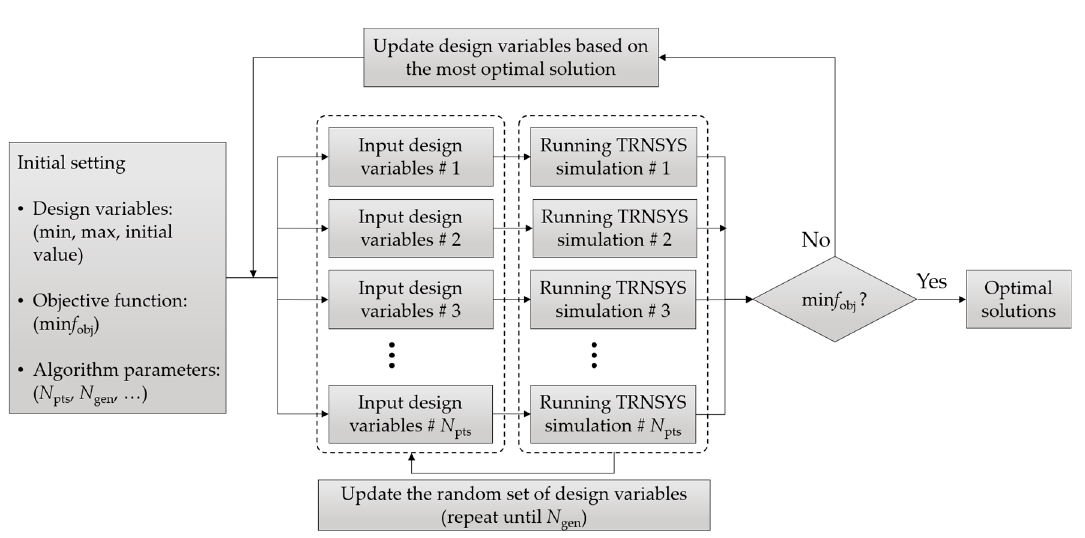
Figure 5. Particle swarm optimization (PSO) algorithm with TrnOpt and TRNSYS.